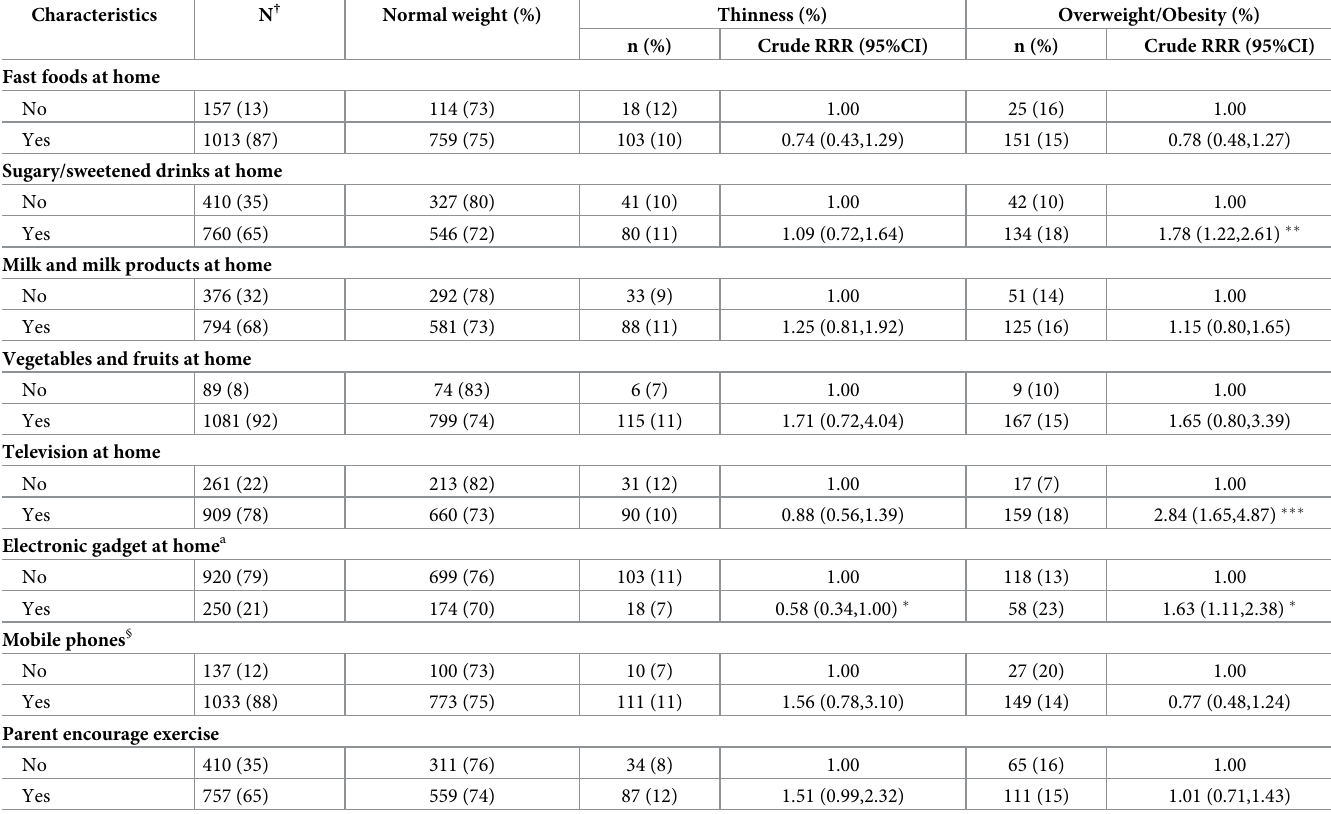
Table 2. Home environment correlates for overweight and obesity (N = 1170). Characteristics